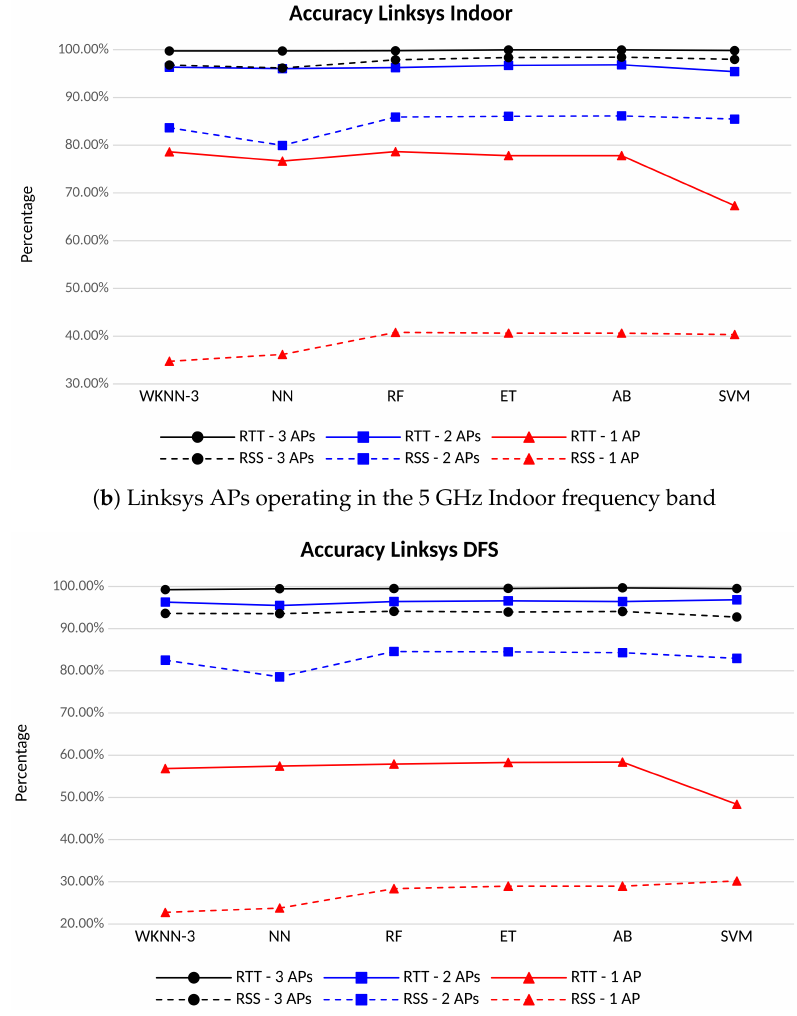
Figure 11. Accuracy for different ML algorithms and number of APs of the same vendor and channel. FTM-based in solid lines, RSS-based in dashed